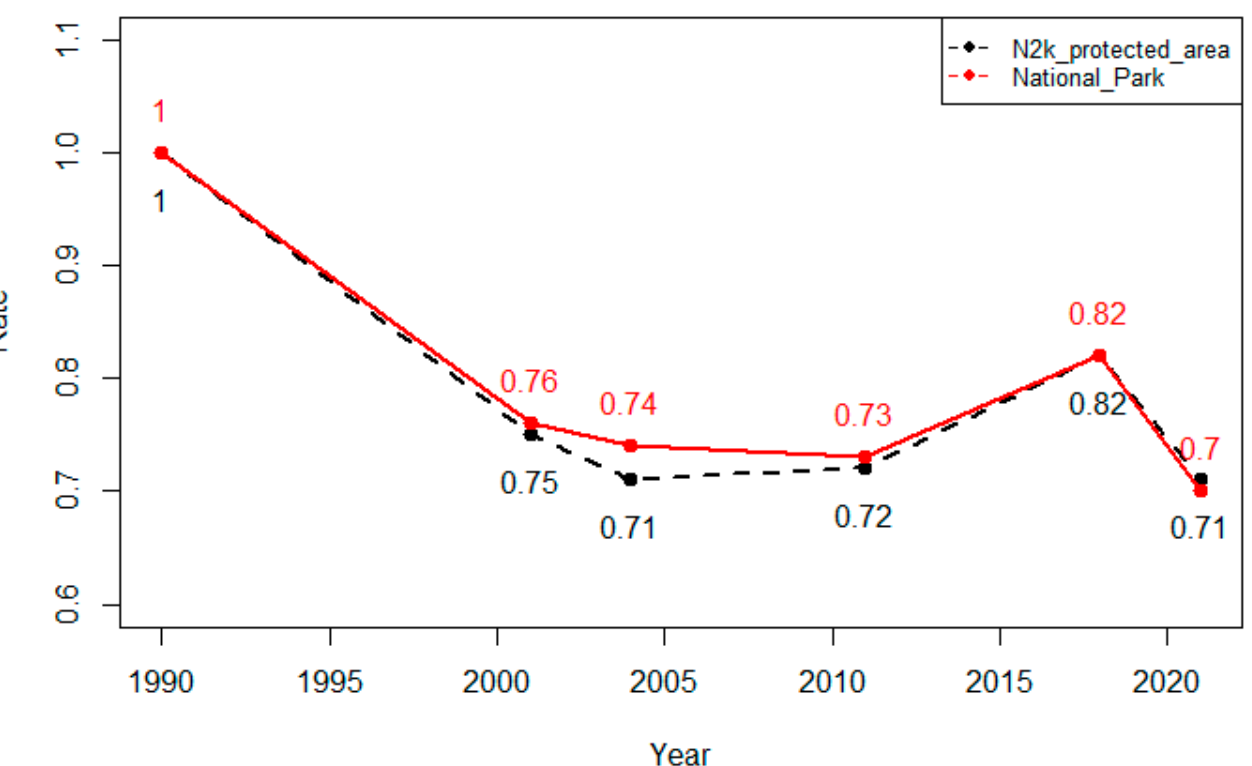
Figure 10. Temporal trend of SDG 15.1.2 indicator for grasslands within N2K PA and National Park boundaries during the period 1990–2001 resulted from time series of classified mappings and nor- malized to the 1990